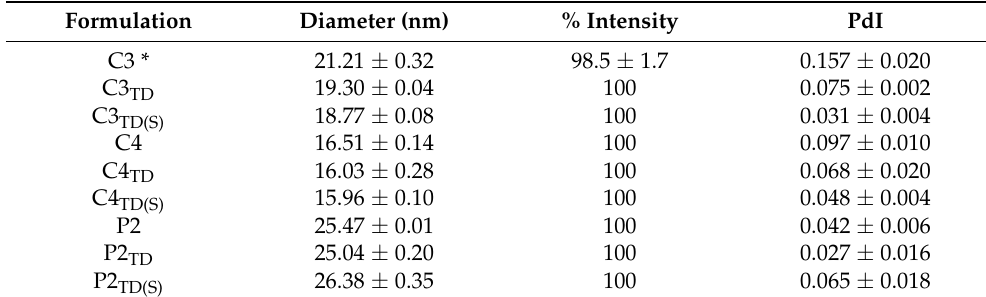
Table 4. Globule size distribution by the intensity of placebo and TD-loaded NE formulations after 50-fold dilution with water or